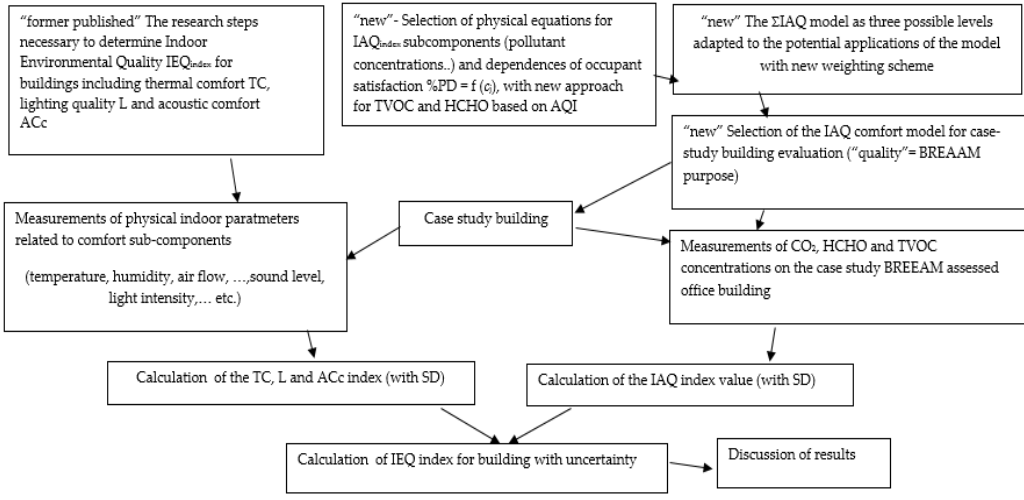
Figure 2. To determine the indoor air quality and indoor environmental quality (IEQ) indexes for the case study. (TC—thermal comfort, L—light quality, ACc—acoustic comfort).